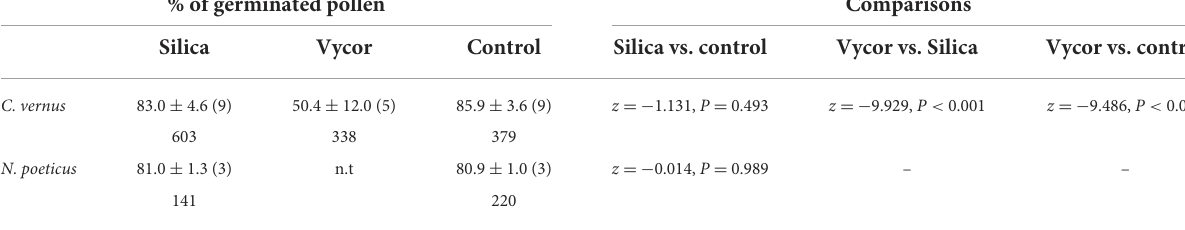
Numberofreplicatesaregiveninparenthesisandbelowthenumberofpollengrainsused.ComparisonsrefertoTukeypost-hoctests.